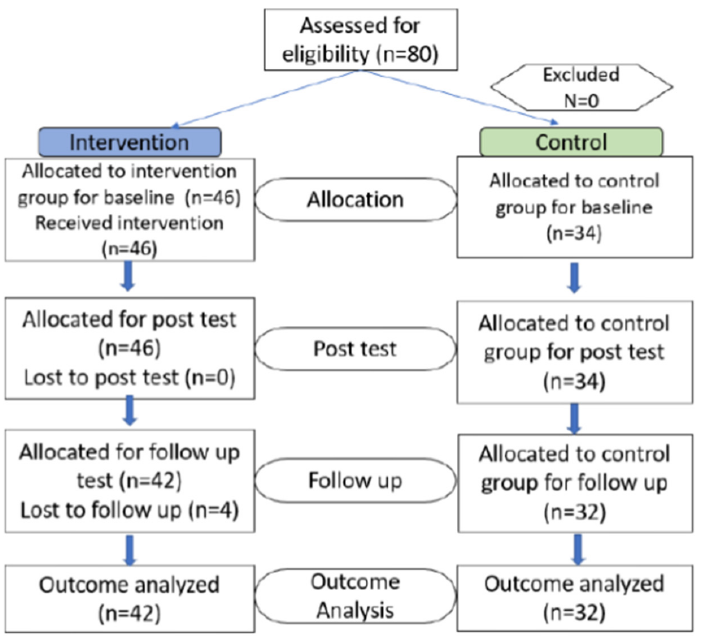
Figure 1. Participant flowchart of the study according to the CONSORT 2010 guidelines.